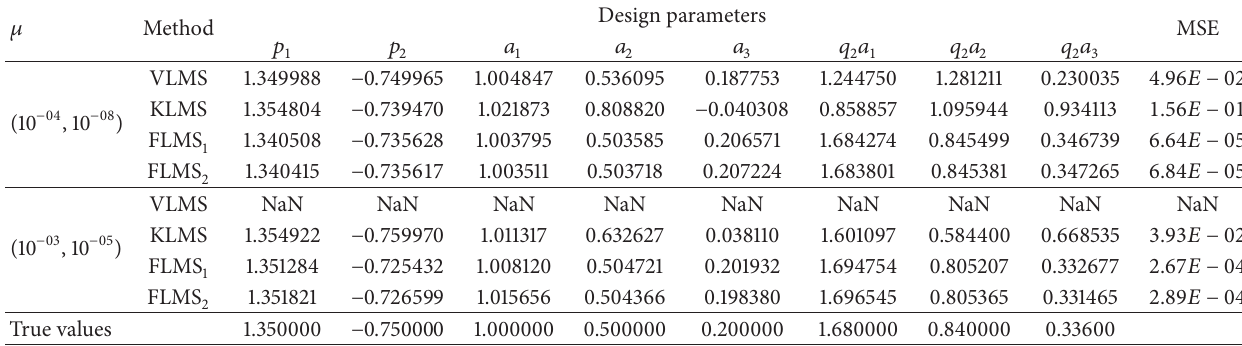
Table 4: Comparison of proposed results against true values of INCAR model for 3dB